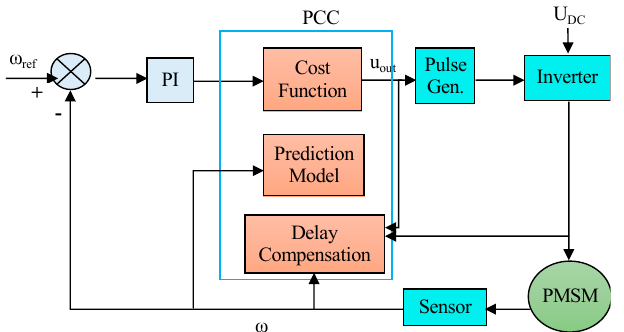
Figure 3. Basic structure of the PMSM PCC control.